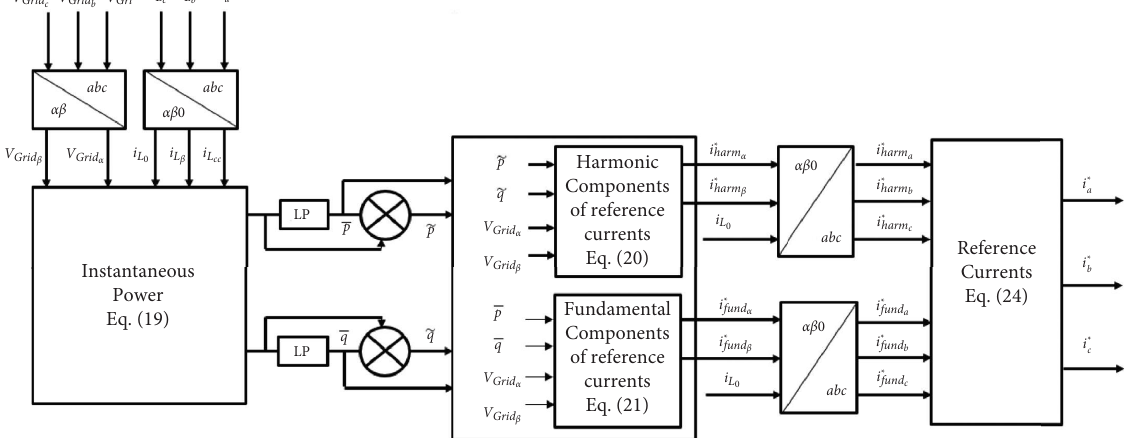
Figure 6: Block diagram of proposed management strategy with PQ